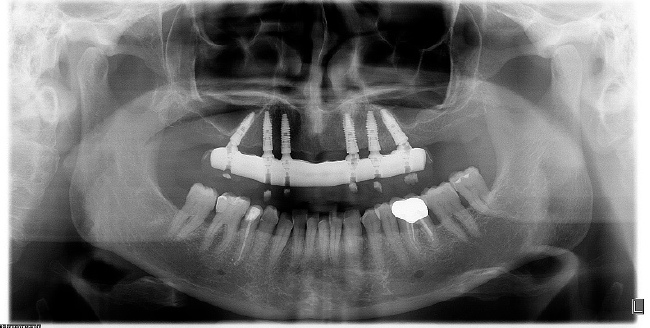
Figure 9. Panoramic radiograph at follow-up.